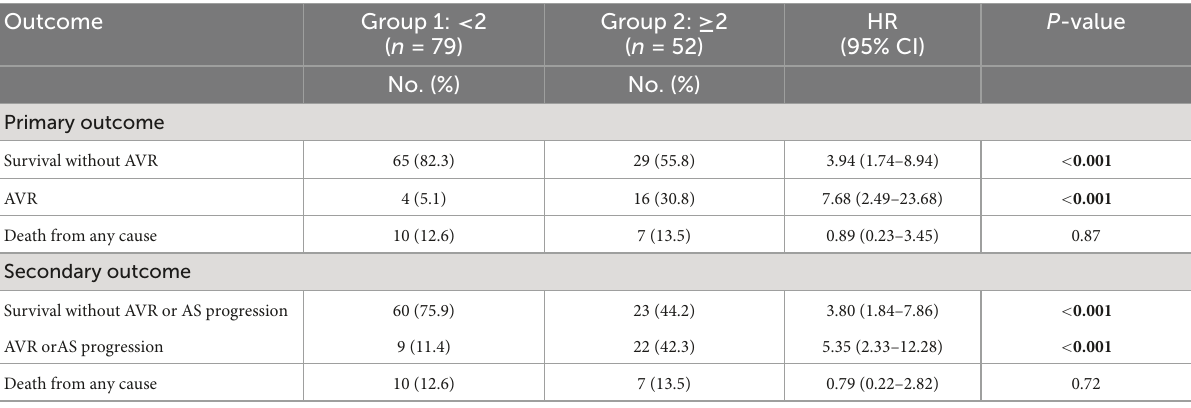
TABLE 3 Outcomes in moderate aortic stenosis